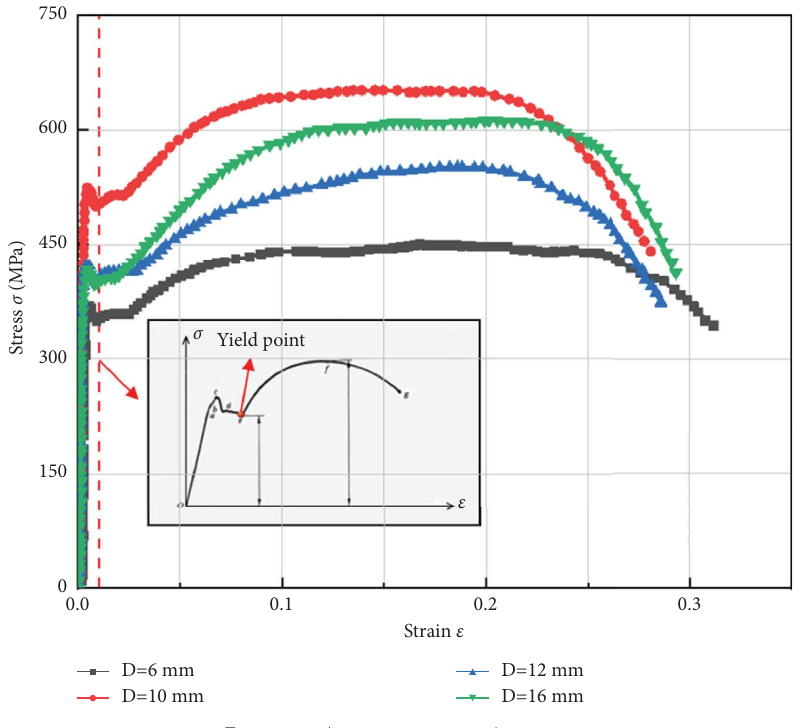
Figure 7: Average stress-strain curve. Table 2: Mechanical properties of steel